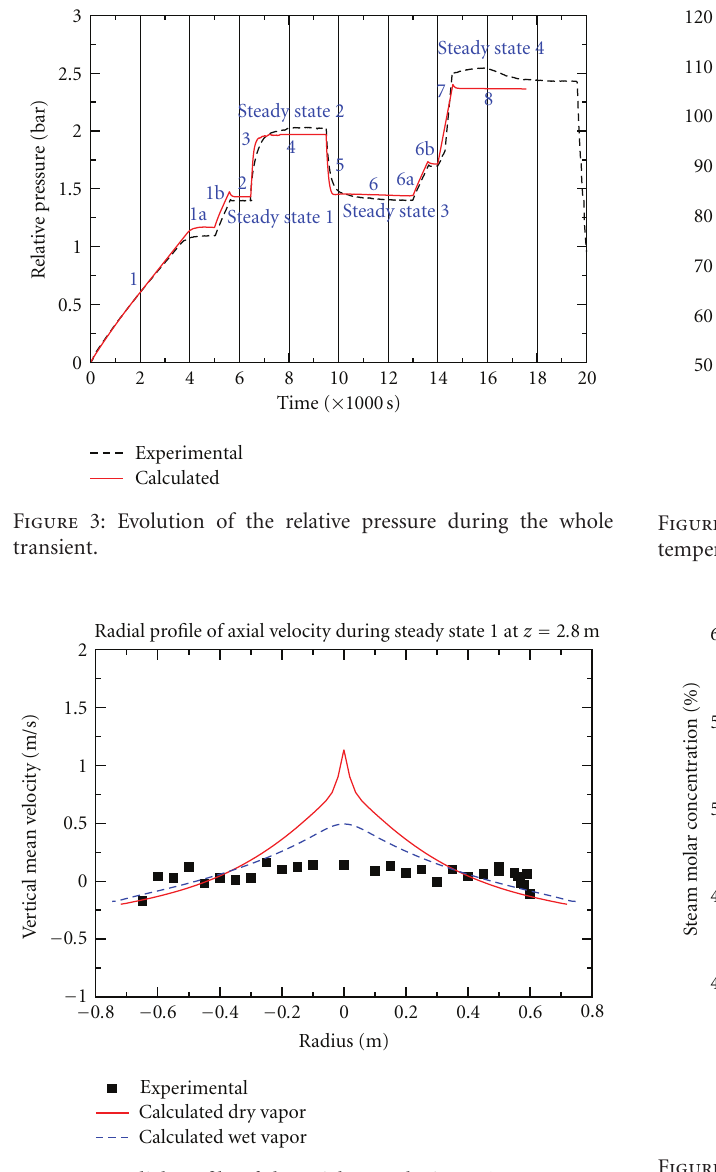
Figure 4: Radial profile of the axial gas velocity at Z 10 = 2 . 8m: steady state 1.